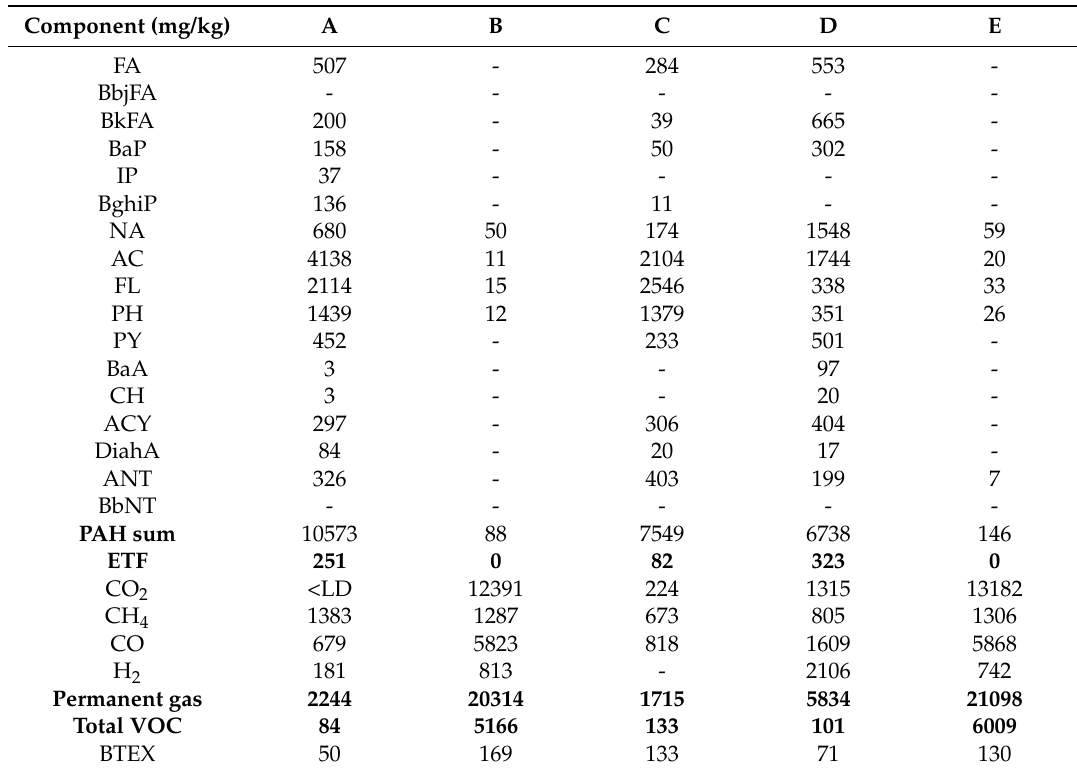
Table 10. PAH and ETF comparison. LD: Limit of